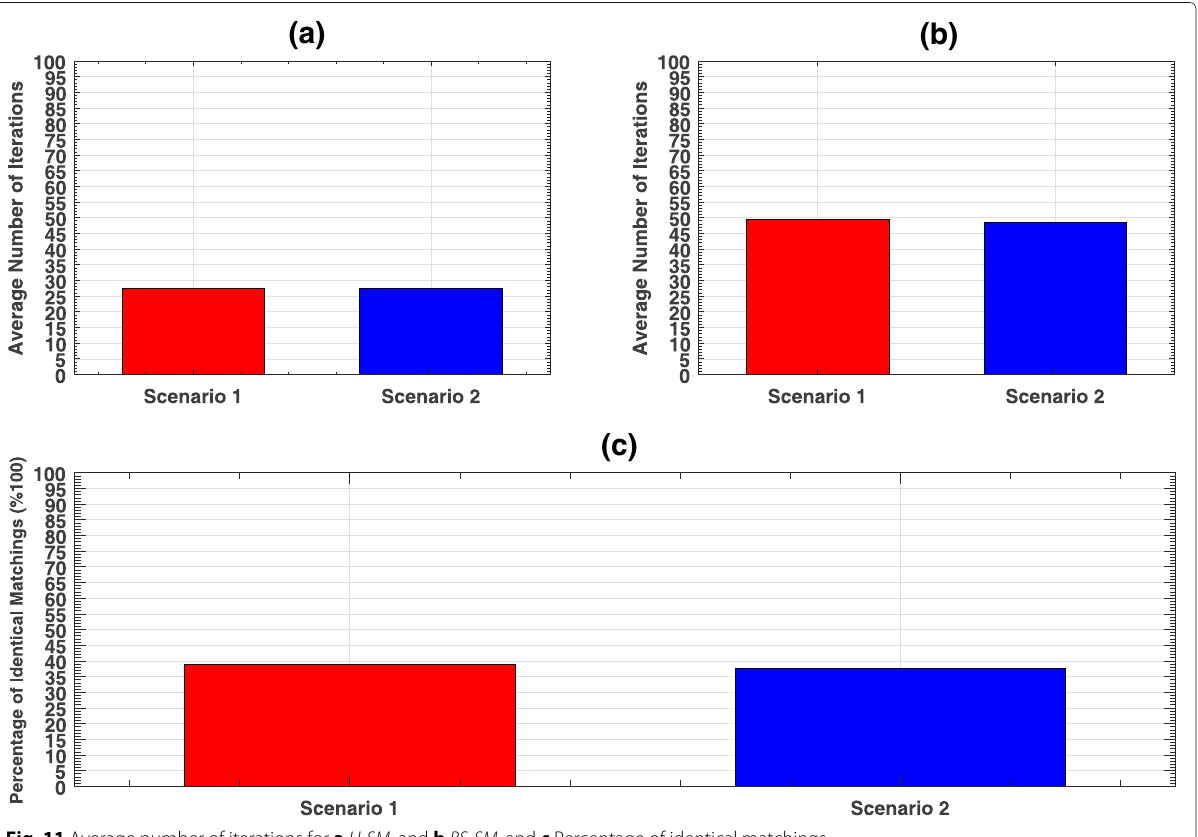
Fig. 11 Average number of iterations for a U-SM , and b BS-SM , and c Percentage of identical matchings